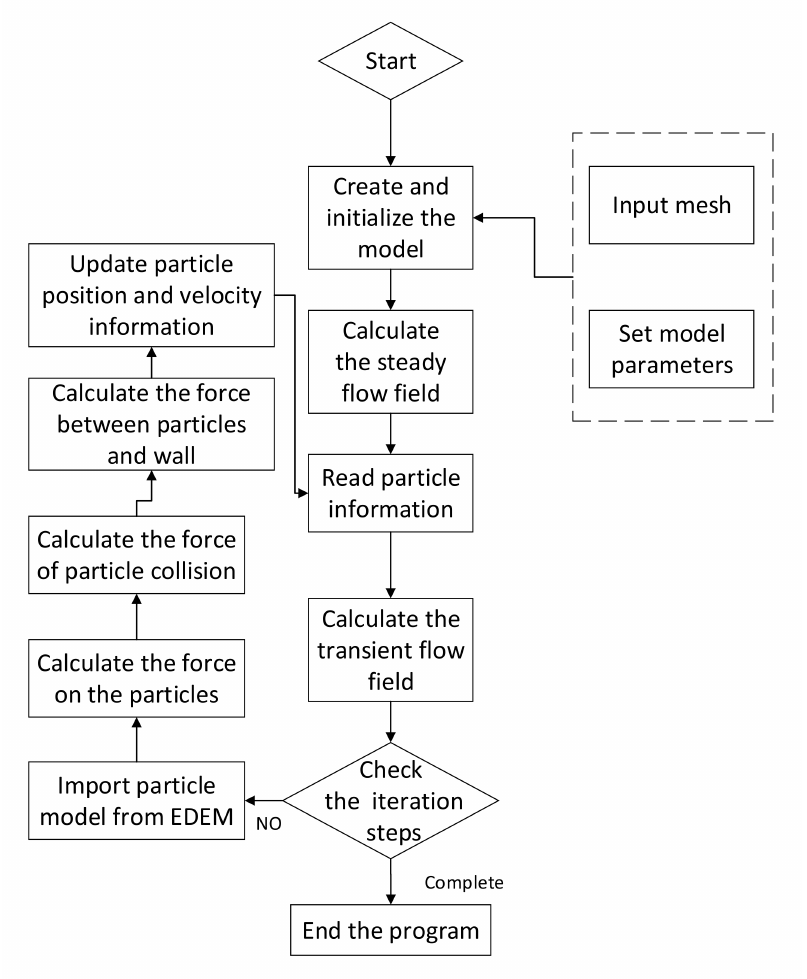
Figure 1. Calculation process.